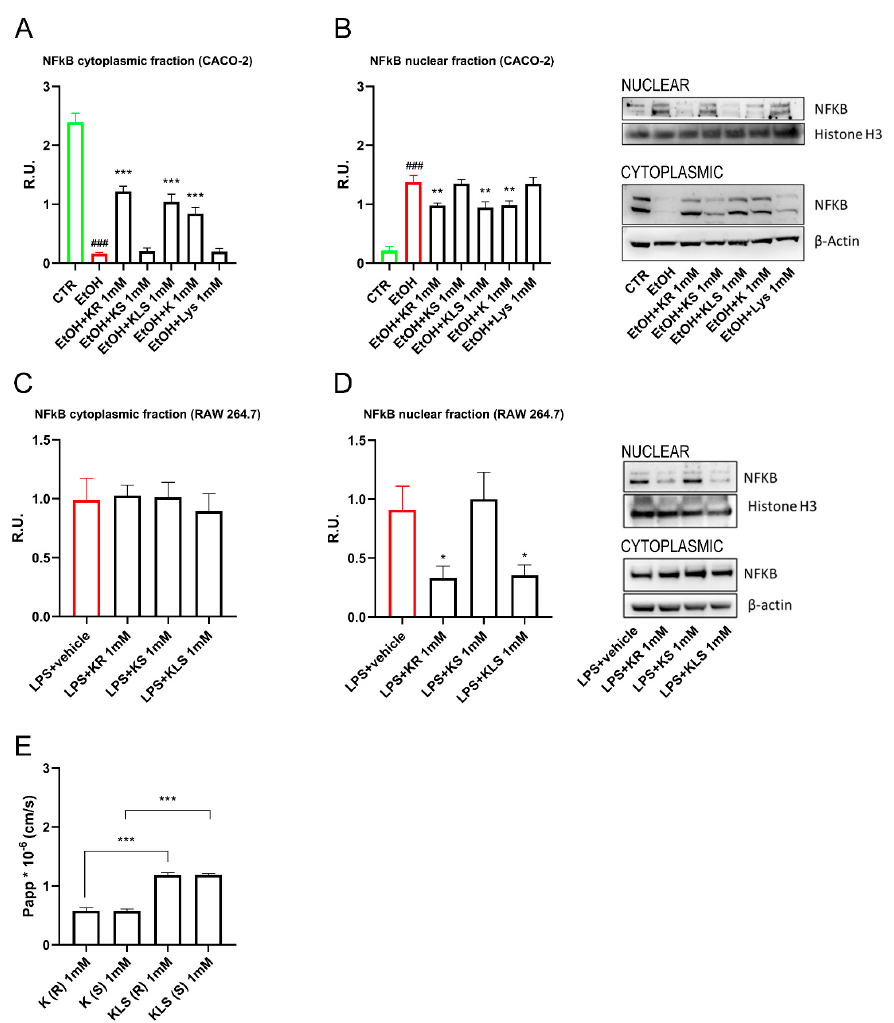
Figure 7. WB analysis for cytoplasmatic and nuclear components of NF κ B ( A , B ) Caco-2 cells and ( C , D ) LPS-activated RAW 264.7 upon R or S enantiomer of K and K, KLS, Lys for 24 h. One way ANOVA was performed: ***, p < 0.0001; **, p < 0.005; *, p < 0.05; vs. EtOH; ###, p < 0.0001 EtOH vs. CTR. One-way ANOVA: * p < 0.05 vs. LPS vehicle (CTR) n = 3. The image blot is a representative one. ( E ) Permeability assay of Caco-2 cells upon R or S enantiomer of K, KLS. One-way ANOVA was performed: ***, p < 0.0001; **, p < 0.005 vs. EtOH. One-way ANOVA: * p < 0.05 vs. LPS vehicle (CTR) n = 3.